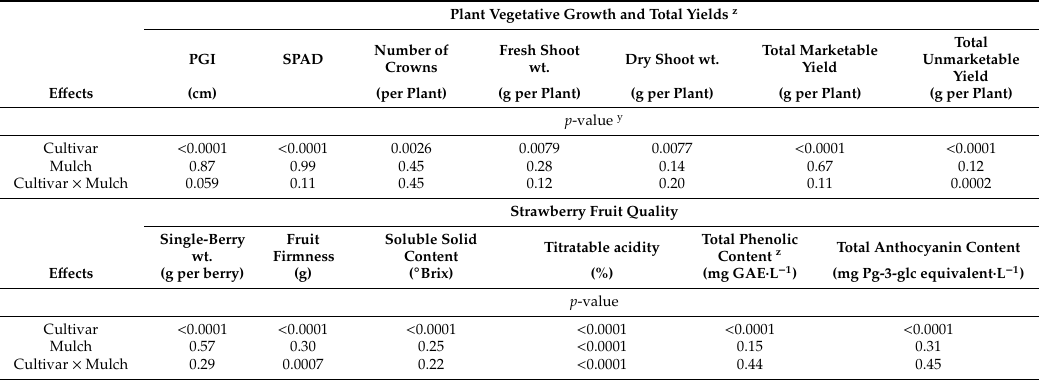
Table 1. A summary of analysis of variance for the e ff ects of strawberry cultivar, mulch type, and the interaction between cultivar and mulch on all tested variables including plant growth index (PGI), leaf soil plant analysis development (SPAD) readings, number of crowns per plant, fresh and dry shoot weights, total marketable and unmarketable fruit yield, single-berry weight, fruit firmness, soluble solid content, titratable acidity, total phenolic content, and total anthocyanin content. GAE, gallic acid equivalent; Pg-3-glc, pelargonidin-3-glucoside.